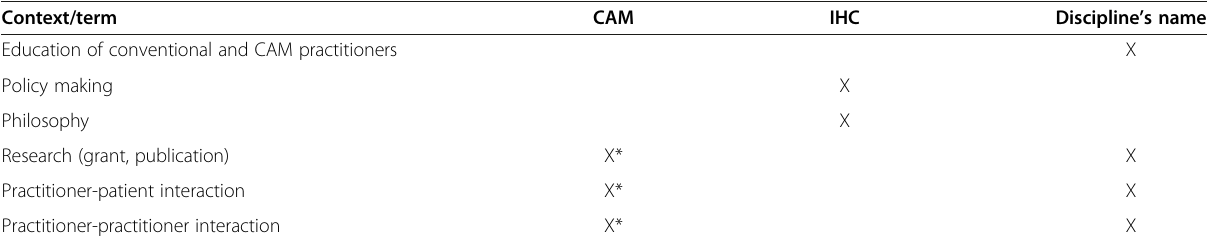
Table 1 Context of use of CAM-related terms